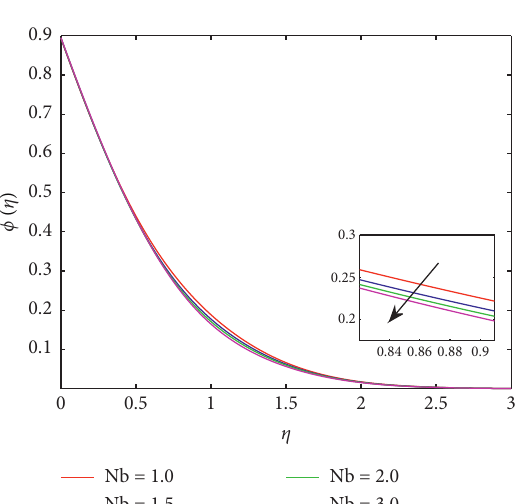
Figure 21: Variation due to δ